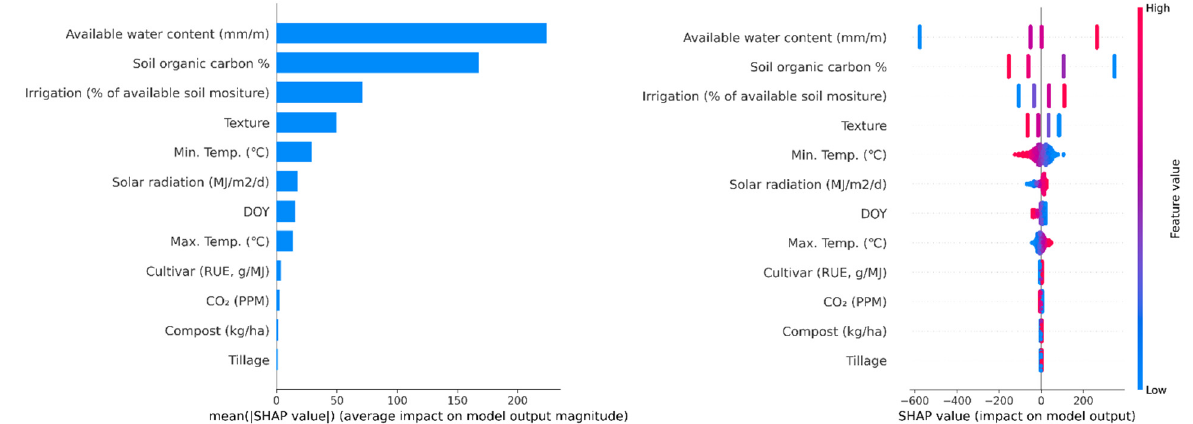
Figure 7. Feature importance for ET (mm) based on SHAP-values for the lasso regression model. On the left , the mean absolute SHAP-values are depicted to illustrate global feature importance. On the right , the local explanation summary shows the direction of the relationship between a feature and the model output. Positive SHAP-values are indicative of increasing grain yield whereas negative SHAP-values are indicative of decreasing grain yield.